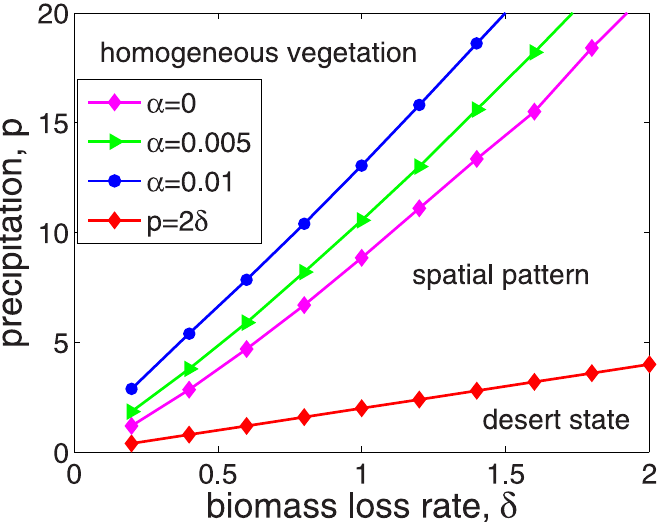
Fig 3. Effects of α on the instability region for equilibrium E + on p − δ plane. The parameter values v = 182.5. One can see that stronger infiltration feedback (larger α ) leads to larger instability region.